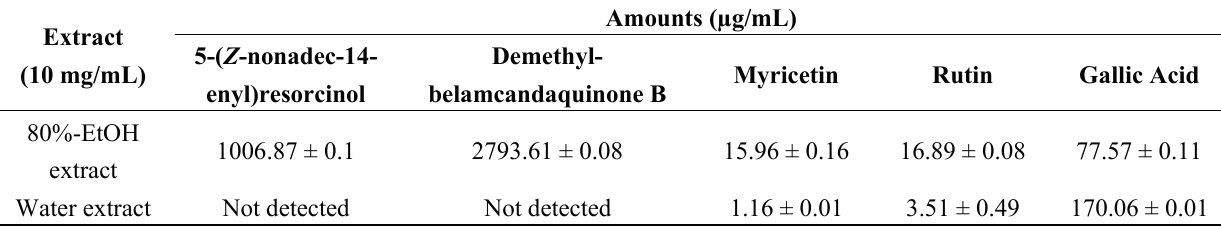
Table 1. Amount of major compounds found in Labisia pumila var. alata (µg/mL) obtained from HPLC quantification